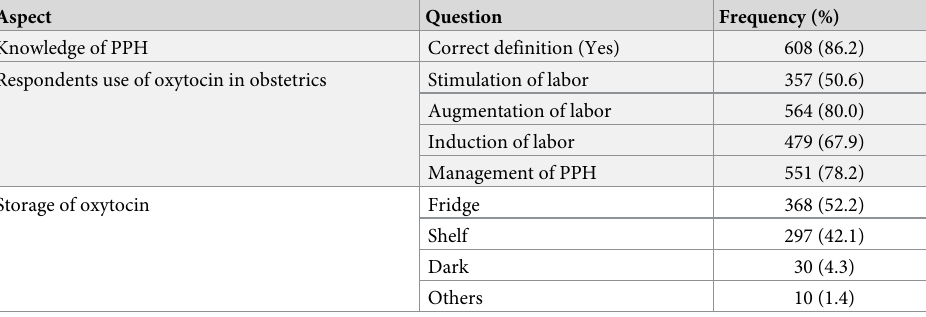
Table 3. General obstetrics knowledge and practice of the respondents (n =